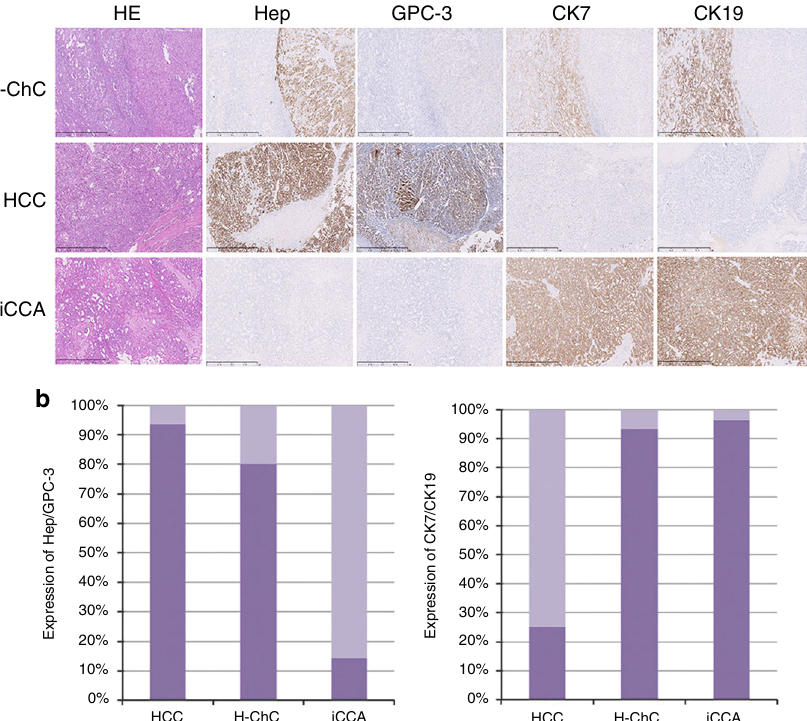
Fig. 2 Immunohistochemical pro fi les of liver cancer. a The tumor cells show immunoreactivity for Heptocyte (Hep), GPC-3, CK7, and CK19 in H-ChC (P6). Immunocreativity for Hep and GPC-3 are observed in HCC. Tumor cells are positive for CK7, CK19 in iCCA. b The columns show the expression level of Hep/GPC3 and CK7/19 in H-ChC, HCC, and iCCA. The scale bar represents 1